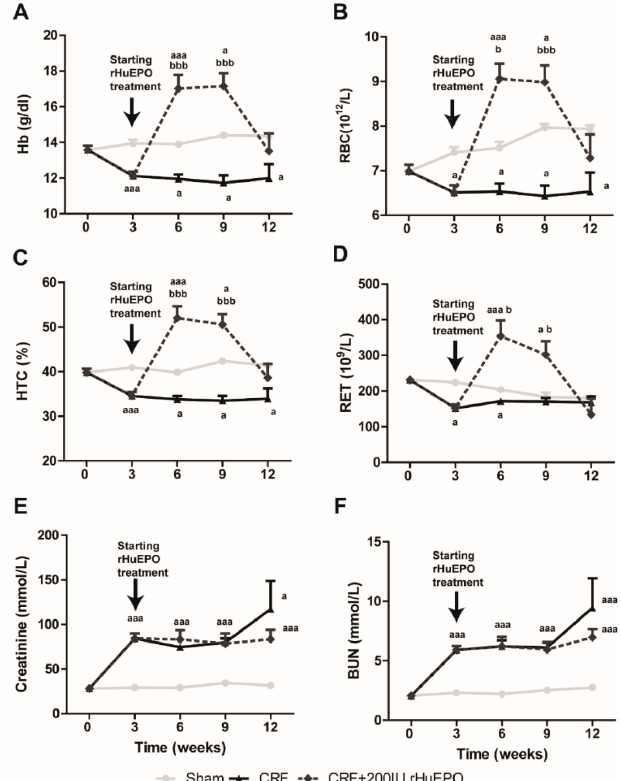
Figure 1. Hematological and renal data throughout the follow-up period of 12 weeks: hemoglobin concentration ( A ); red blood cell count ( B ); hematocrit ( C ); reticulocyte count ( D ); creatinine ( E ); and BUN concentrations ( F ). Results are presented as mean ± SEM (seven rats per group): a: p < 0.05 and aaa: p < 0.001 vs. Sham; b: p < 0.05 and bbb: p < 0.001 vs.